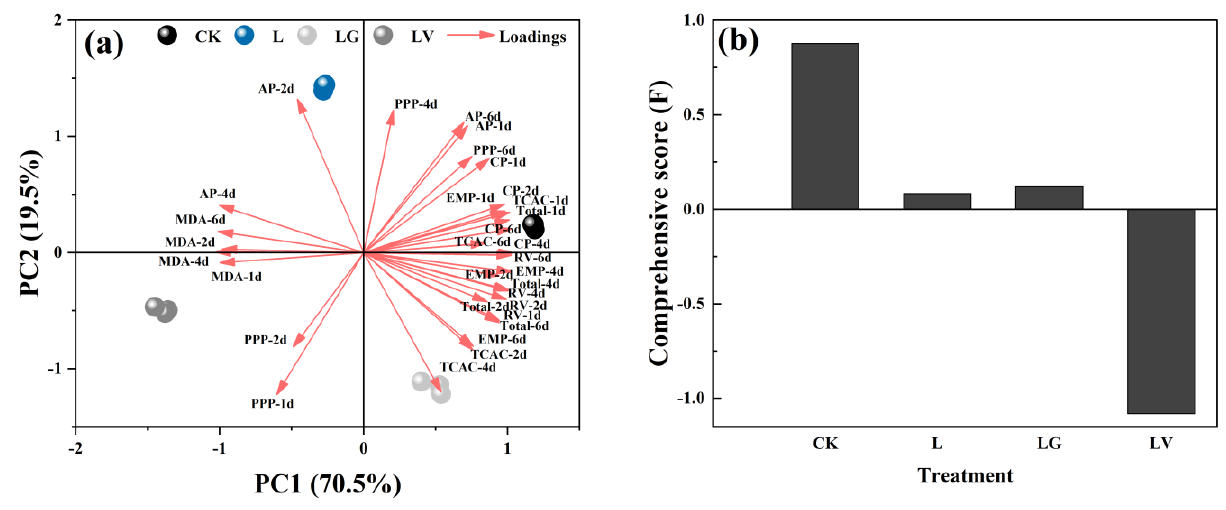
Figure 6. ( a ) Two-dimensional analysis diagram of eigenvectors of PC1 and PC2. The direction and length of the arrow represent the correlation and correlation intensity of the parameters, respectively. The biplot by principal component analysis (PCA) illustrates factors involved in root respiratory activity, root vitality, and MDA content in Malus baccata (L.) Borkh. roots after GABA or VGB application under suboptimal low root-zone temperatures from days 1 to 6. ( b ) The comprehensive score (F) and ranking of four treatments. F = F1 × 70.50% + F2 × 19.50%; F1, PC1 score; F2, PC2 score; F1 = α 1 (Root vitality on day 1) × Z Root vitality on day 1 + α 1 (MDA on day 1) × Z MDA on day 1 + + α 1 (PPP on day 6) × Z PPP on day 6; F2 = α 2 (Root vitality on day 1) × Z Root vitality on day 1 + α 2 (MDA on day 1) × Z (MDA on day 1) + + α 2 (PPP on day 6) × Z PPP on day 6. Z-standardized values calculated in SPSS software. Treatments legend as in Figure 1. The PCA loadings and scores are presented in Supplementary Materials.